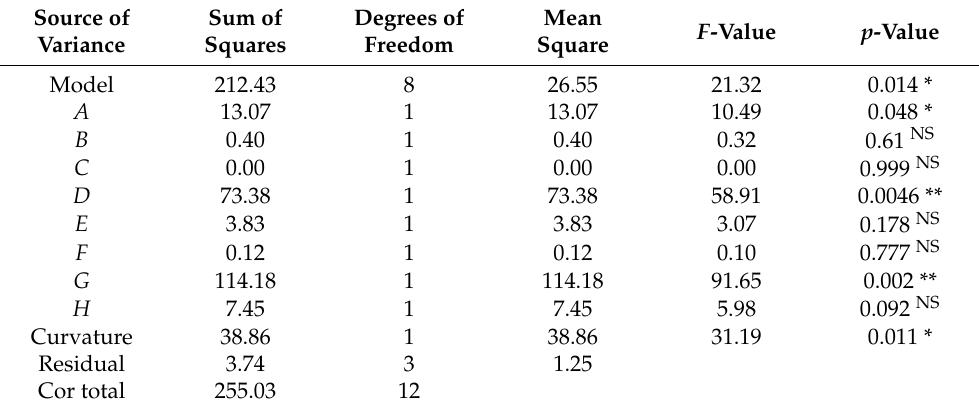
Table 4. The variance analysis results of the Plackett–Burman Design with the analysis module in